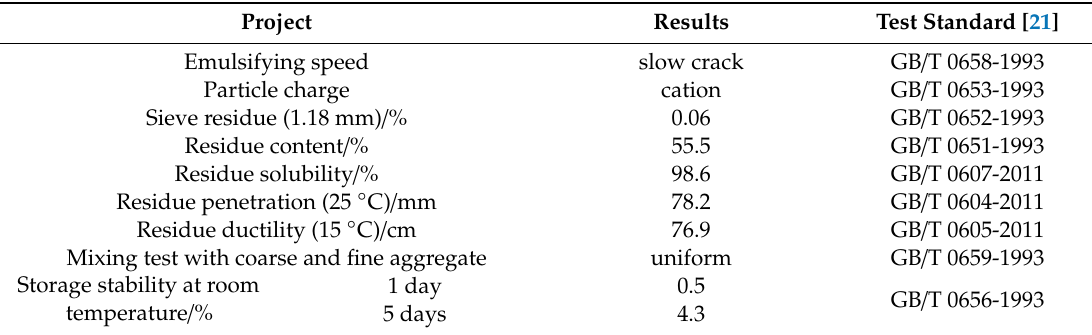
Table 6. Cationic emulsified asphalt technical